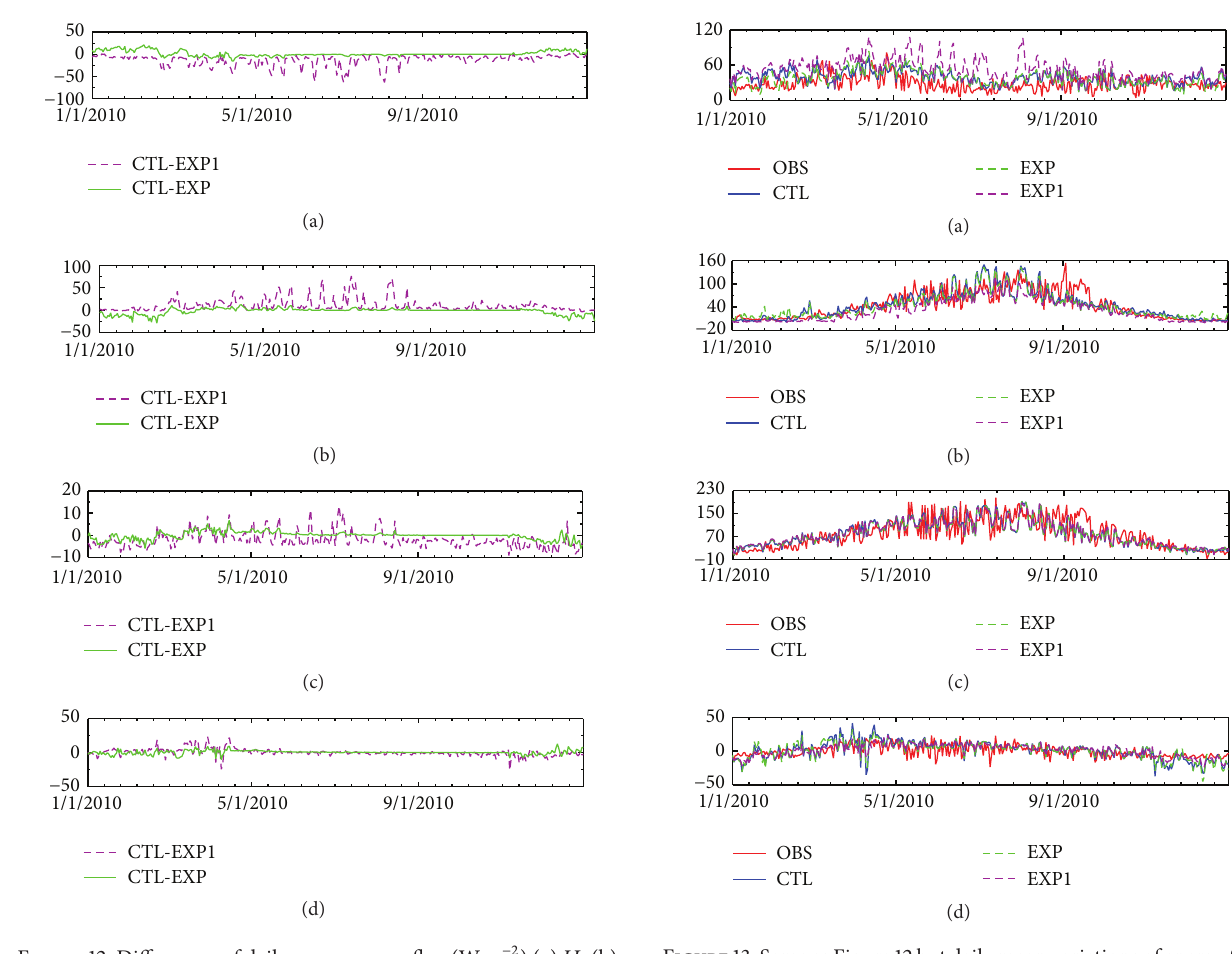
Figure 12: Differences of daily mean energy flux (Wm −2 ) (a) 𝐻 , (b) LE, (c) 𝑅 𝑛 , and (d) 𝐺 between the CTL and EXP simulations at ZS site.